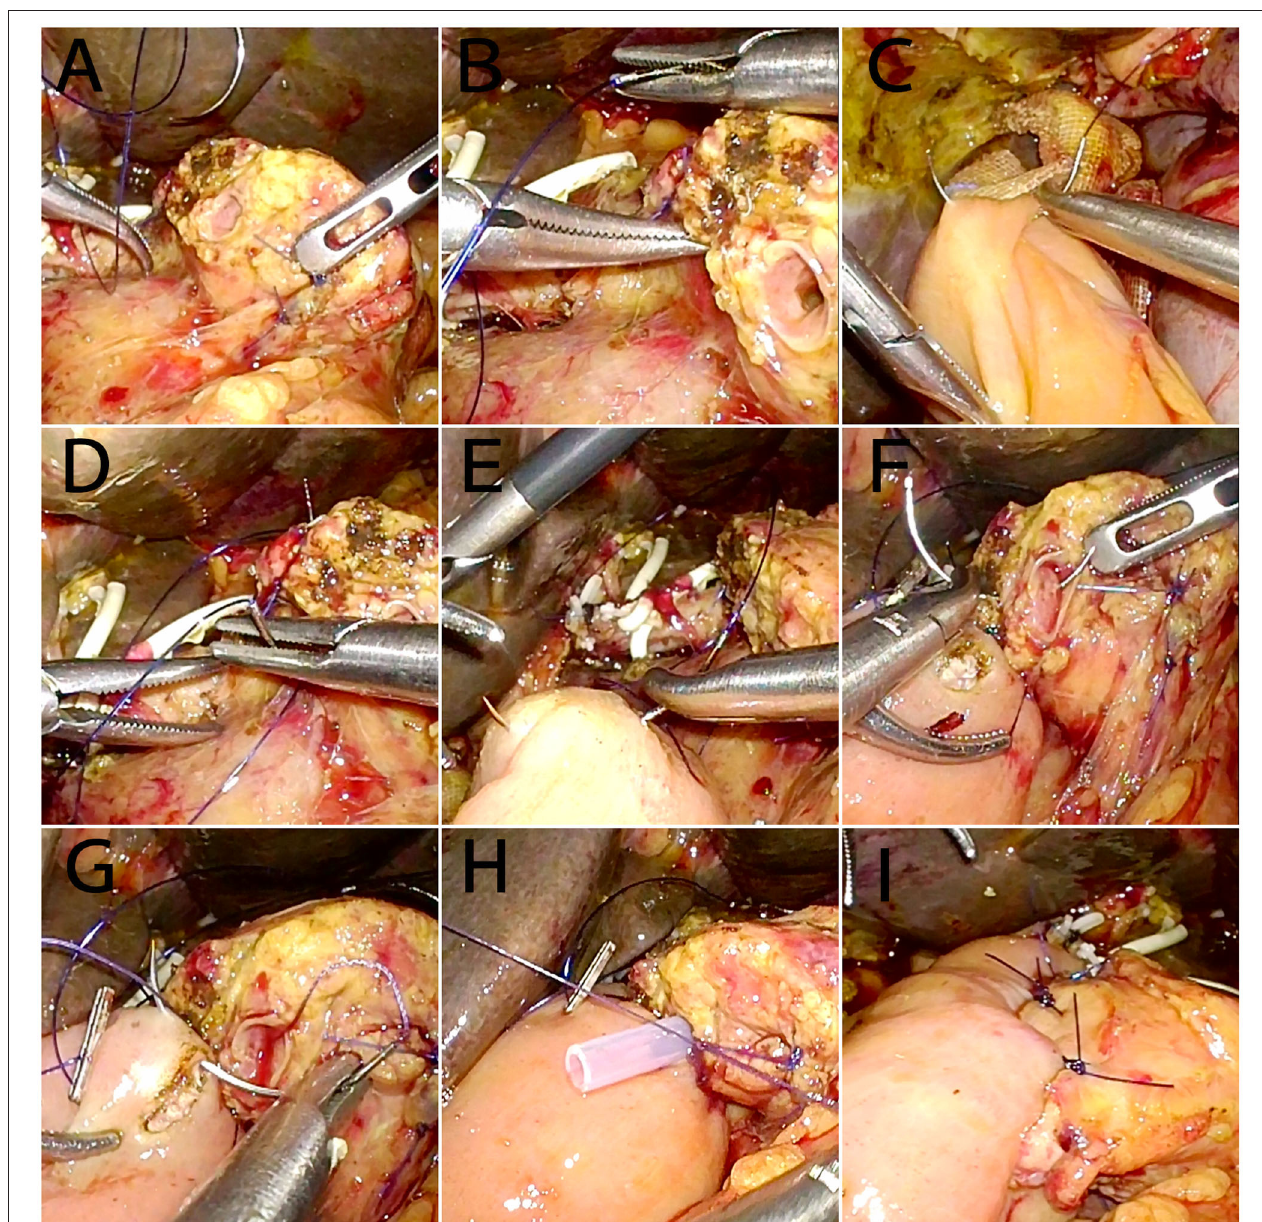
FIGURE 3 | Intraoperative images of the modified Blumgart pancreaticojejunostomy procedure. (A) The specimen has been removed; pancreaticojejunostomy proceeds next. (B) At 1.5cm from the edge of the pancreatic stump, a 3-0 large needle penetrates the pancreas. (C) Stitching of the posterior wall of the jejunum. (D) At 0.5cm from the edge of the pancreatic stump (at the same level as the previous stitch), the needle penetrates the pancreas. (E) Stitching of the anterior wall of the jejunum. (F,G) Stitching of the pancreatic duct and jejunal mucosa. (H) An internal pancreatic stent is placed, and the duct-to-mucosa anastomosis is continued. (I) After suturing using 4–5 needles, all sutures were